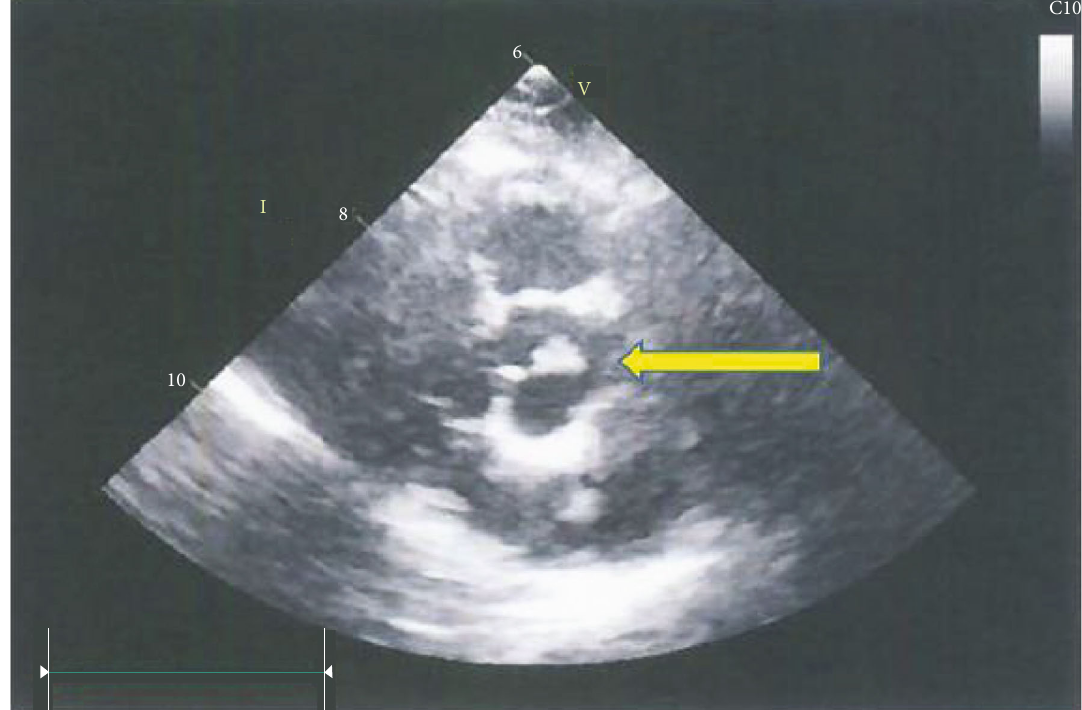
Figure 2: Transthoracic echocardiography: parasternal short axis shows a round mass, 9 mm in diameter (yellow arrow), on the aortic side of the right coronary cusp of the aortic